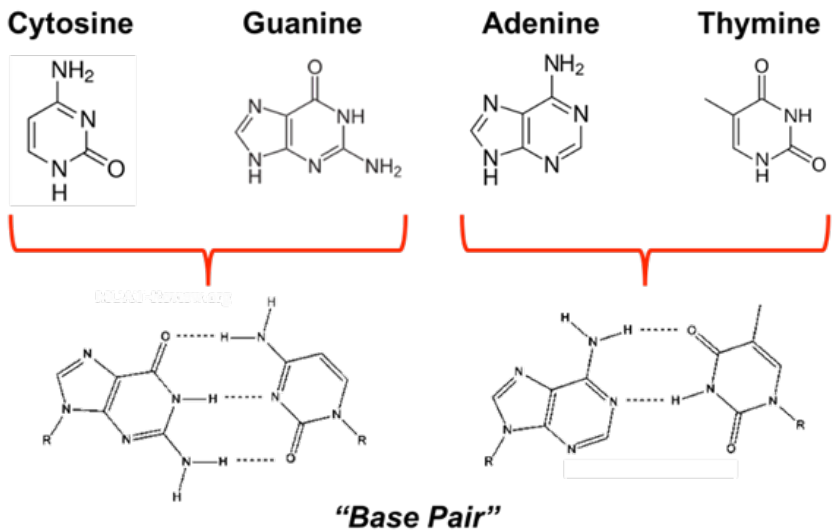
Figure 2. Structures of primary DNA nucleobases that form base pairs through hydrogen-bonding.